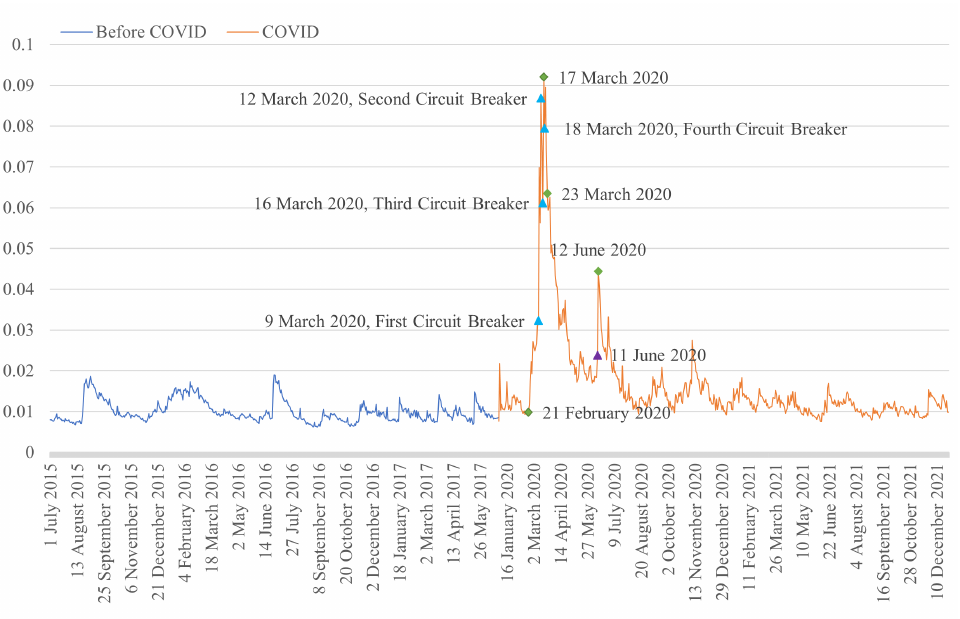
Figure 2. CES before and during COVID-19 epidemic in US financial market. The blue line represents the CES before the outbreak of the COVID-19 pandemic, and the orange line represents the CES after the